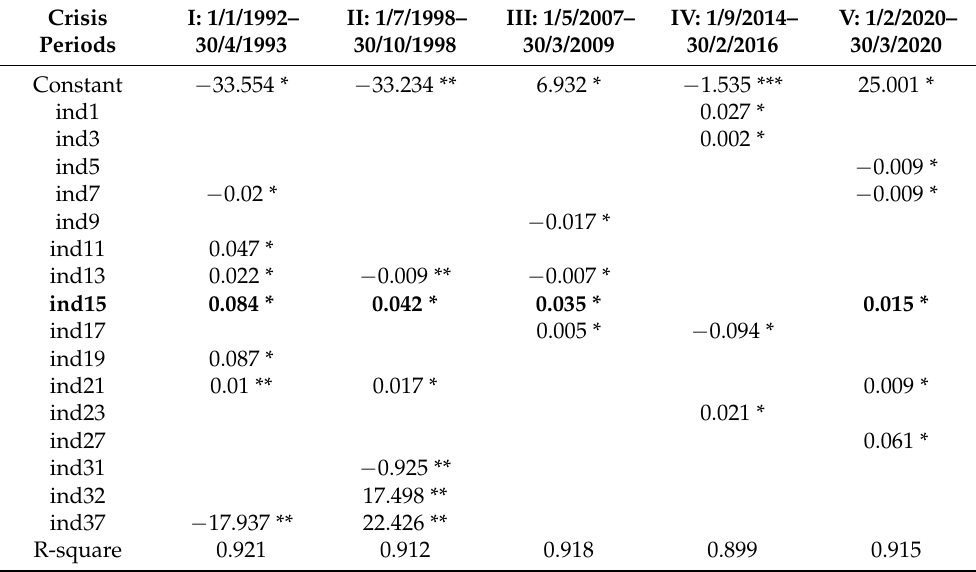
Table 3. Indexes in multiple linear regression models of the Bank of Nova Scotia during the 5 crisis